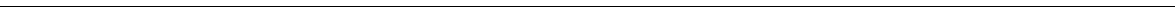
Figure 3 | Necrotic morphology of PI-positive cells at the bone surface. ( a ) PI foci at the bone surface. Cryosections of the forelimb zeugopod of an E14.5 embryo injected with AO and PI were observed by fluorescence microscopy, and then the sections were stained by haematoxylin and eosin (H&E). Scale bar, 100 m m. ( b ) PI foci at sites of calcification (positive for Dahl’s calcium stain). Cryosections of the forelimb zeugopod of an E14.5 embryo injected with AO and PI were observed by fluorescence microscopy, followed by staining with Alizarin Red S. ( c ) PI-positive cells are also positive for TUNEL staining. A vertical cryosection of the forelimb of an E14.5 embryo injected with AO and PI was observed by fluorescence microscopy and then TUNEL staining was performed. Black arrowheads indicate PI foci. Scale bar, 50 m m. ( d ) PI-positive cells are negative for cleaved caspase-3. A vertical cryosection of the forelimb of an E14.5 embryo injected with AO and PI was subjected to immunostaining by an anti-cleaved caspase-3 antibody. ( e ) PI-positive cells show necrotic morphology. PI-positive cells were examined by TEM as described in Methods. Numbers on the electron micrographs correspond to the numbers of the PI-positive cells shown in the left panel. ( (cid:2) ) indicates a PI-negative cell. White arrowheads indicate the lamina limitans. Scale bar, 2 m m. ( f ) Dead cells exhibiting similar morphology to PI-positive cells in an embryo without AO and PI staining. After euthanasia, an E14.5 embryo without injection of AO and PI was rapidly fixed and examined by TEM. The numbered panels are magnifications of the respective regions enclosed by squares on the left micrographs. Cells indicated by asterisks in panels 4 and 5 are normal cells with an intact plasma membrane. White arrowheads indicate the lamina limitans. ER, endoplasmic reticulum, N, nucleus, Mt,